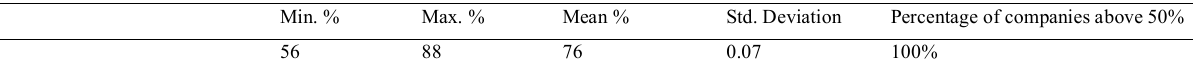
Table 1. Descriptive Statistics of the level of Compliance with Mandatory IFRSs by Companies Listed on the